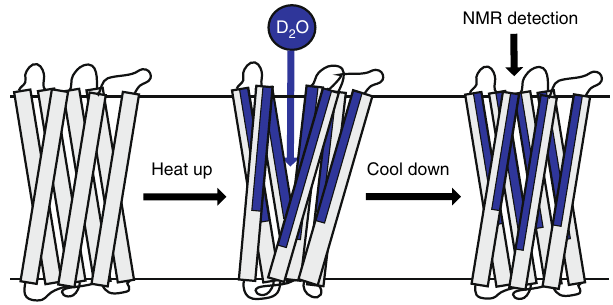
Fig. 1 Schematics of the NMR-detected H/D exchange experiment. The sample is incubated at elevated temperatures, resulting in a gradual temperature-dependent increase of the solvent-accessible surface with amide protons at exposed sites exchanging for deuterons, and subsequently cooled down for SSNMR detection. This cycle is repeated for each elevated temperature point to form a series of NMR spectroscopic snapshots which follow the unfolding pathway. Blue color represents exchanged parts of the